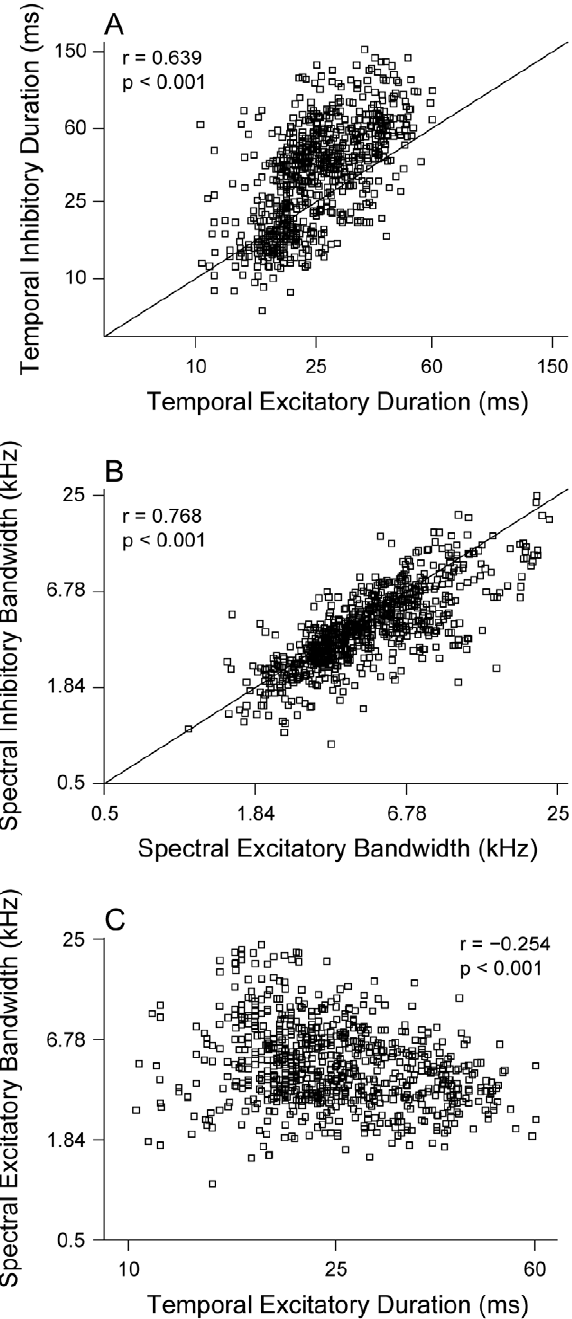
Figure 4. Comparison of temporal and spectral STRF subfield duration and bandwidth. (A) Temporal inhibitory STRF subfield duration versus temporal excitatory subfield duration. Inhibitory duration was longer than excitatory duration (r=0.639, p , 0.001, t- test). (B) Spectral STRF bandwidth for inhibitory versus excitatory subfields. Bandwidth for excitation was generally similar to the bandwidth for inhibition (r=0.768, p , 0.001, t-test). (C) Excitatory STRF subfield bandwidth versus duration. Excitatory bandwidth decreases slightly with increasing duration (r= 2 0.254, p , 0.001, t-test).